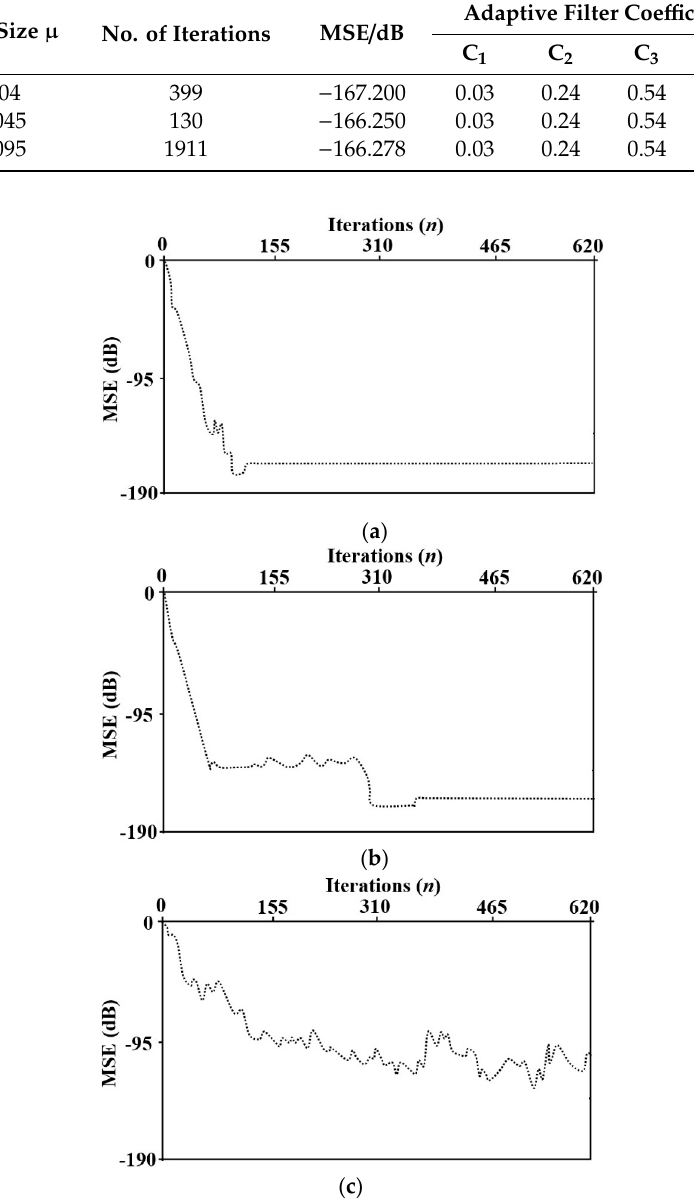
Table 2. Simulation results of the FIR adaptation (colored signal).